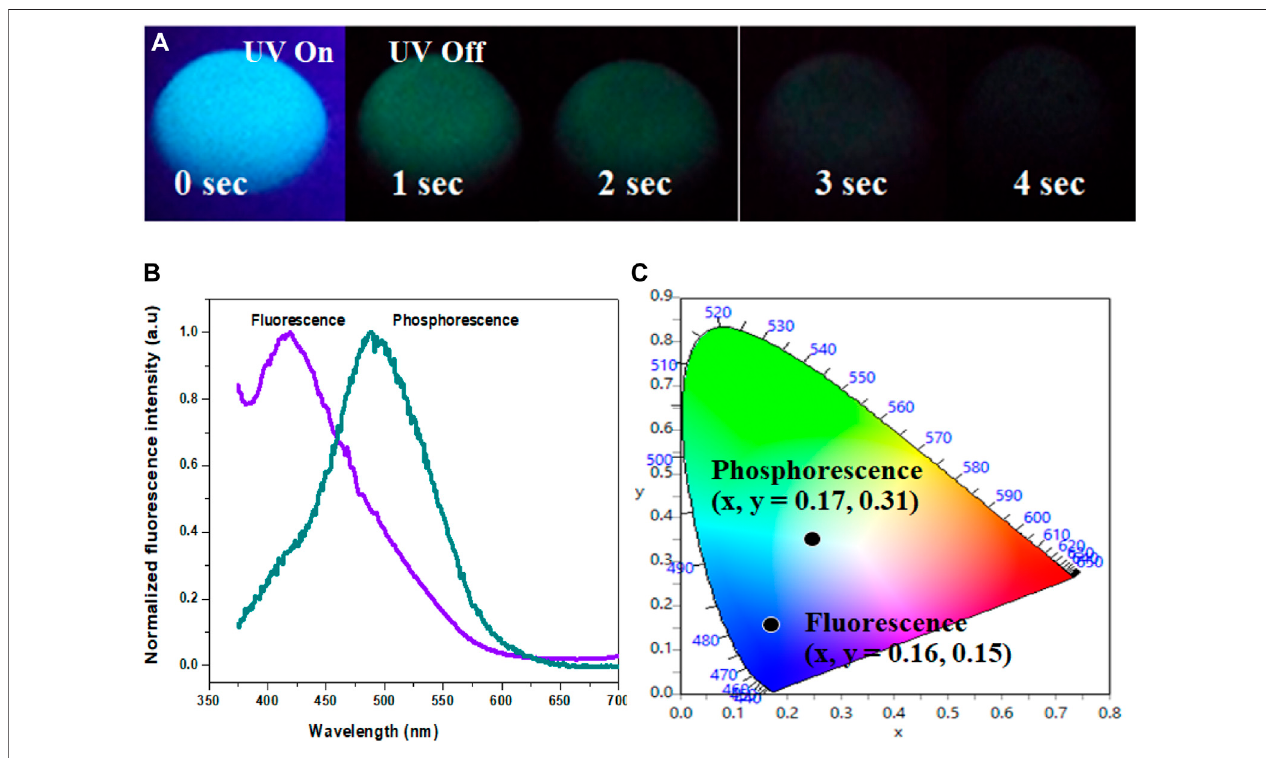
FIGURE 4 | (A) Photograph showing luminescence ( fl uorescence and phsophorescence) of Cl-CNDs (solid state) under 365 nm UV light on and off. (B ) Fluorescence and phosphorescence spectra of Cl-CNDs (C) corresponding CIE chromaticity diagram with color coordinates of (B)